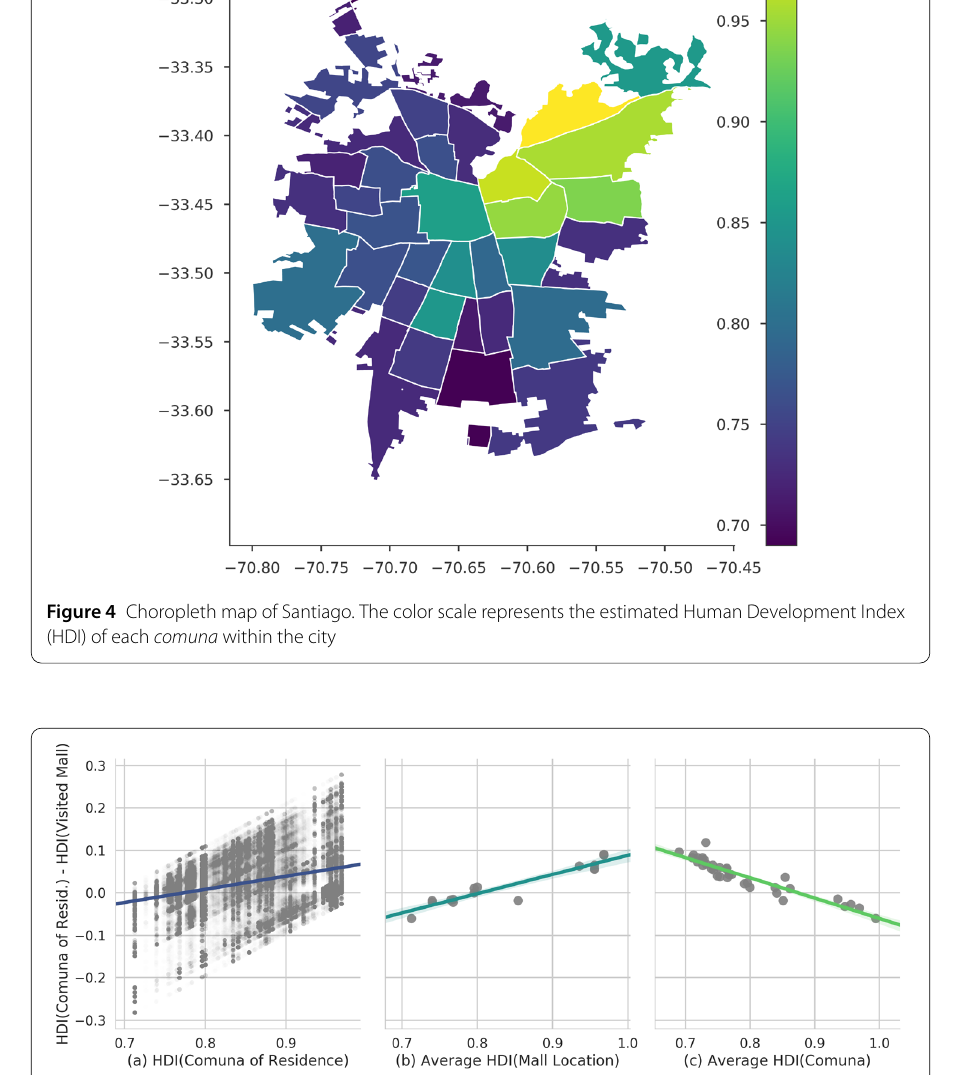
(c) aggregated per comuna of residence ( ρ = –0.9, p < 0.001). In all cases, the